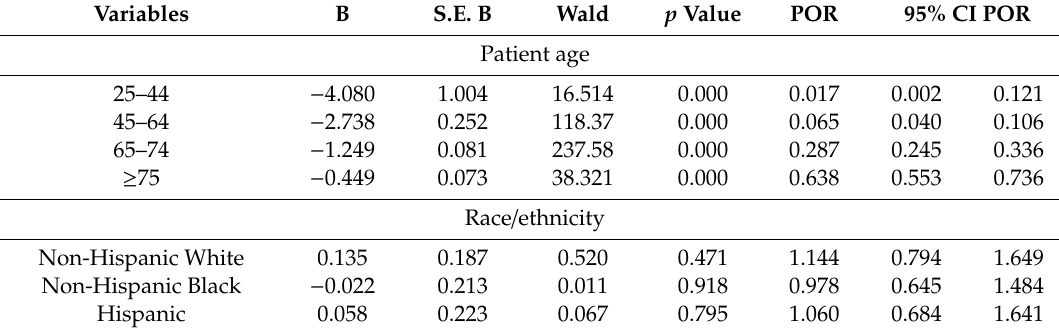
Table 3. Logistic regression analysis results.